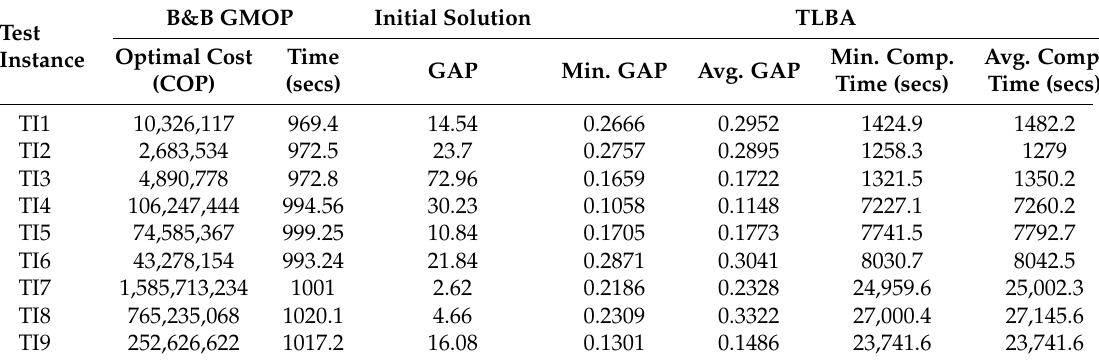
Figure 5. Solution generation process. Table 10. Results for total planning cost and total computational